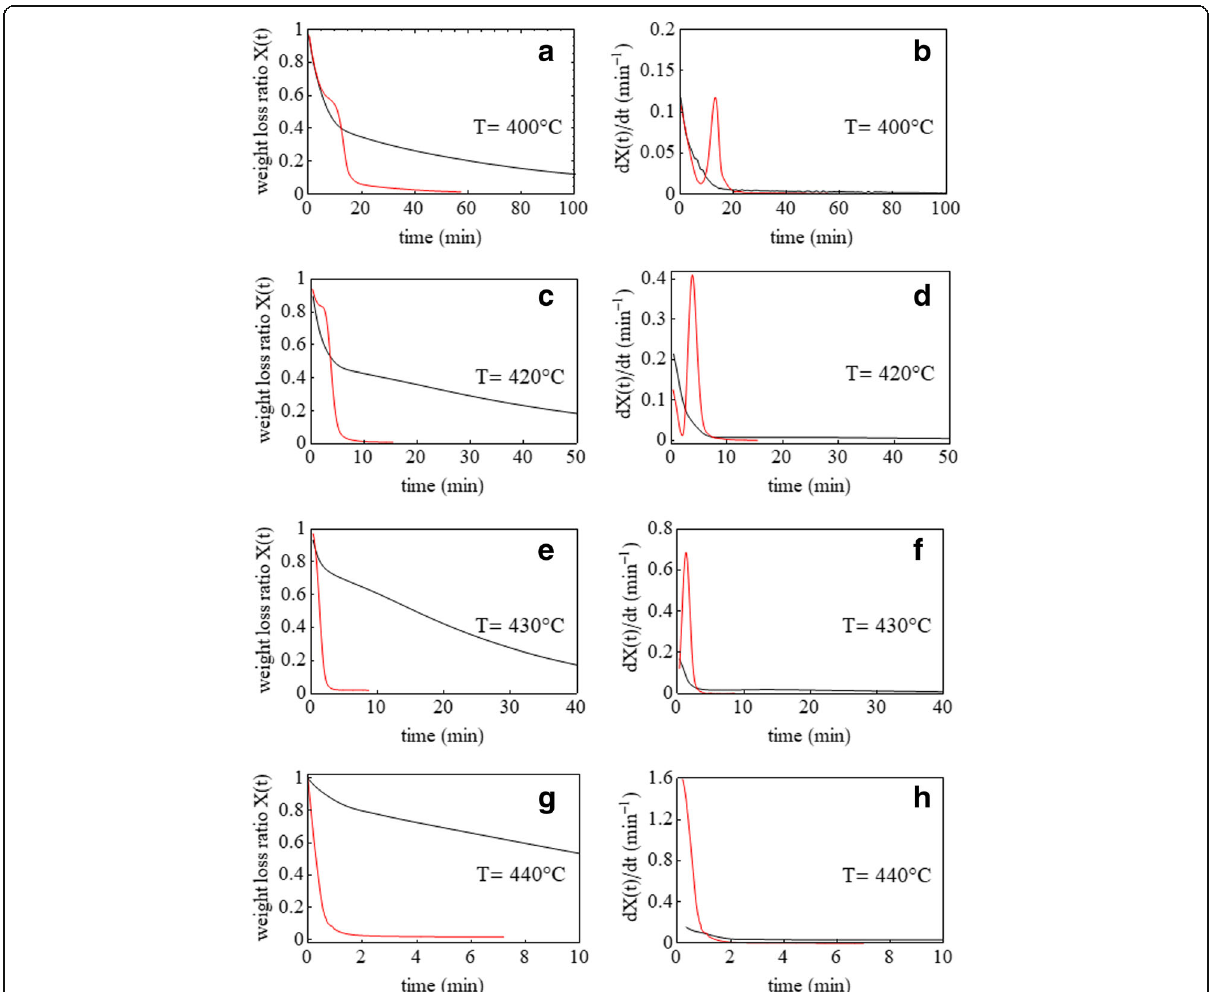
Fig. 4 Isothermal weight loss ratio as a function of time during combustion of pure PVP (black curves) and nano-Pd/PVP (red curves) at 400 °C ( a ), 420 °C ( c ), 430 °C ( e ), and 440 °C ( g ) and corresponding derivative curves ( b , d , f , h )